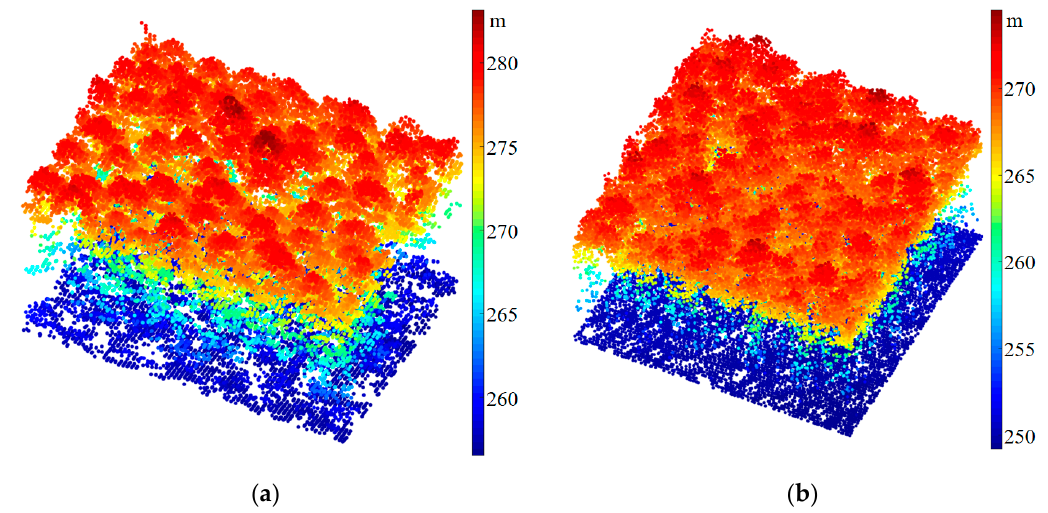
Figure 2. Examples of ALS point clouds for plots with different structural complexities. ( a ) A complex plot A1 that was 30 × 20 m 2 in size. ( b ) A simple plot B4 that was 30 × 30 m 2 in size.